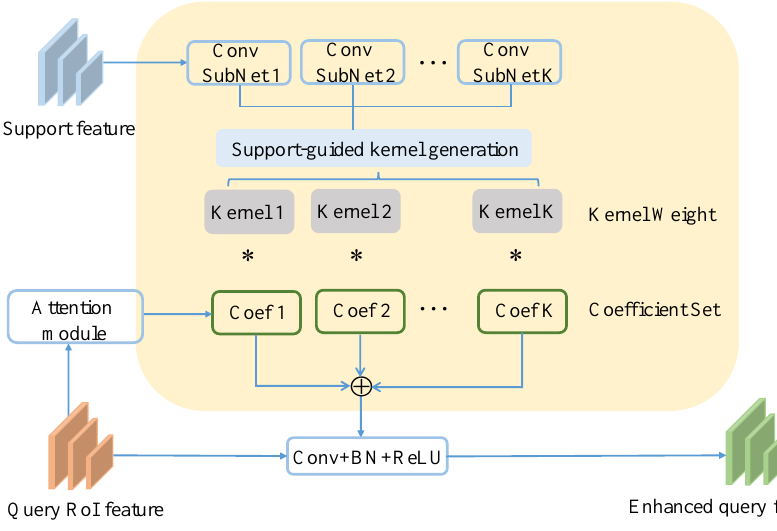
Figure 3. The structure of generating support-related kernel in support-guided query feature en- hancement module. ∗ and ⊕ means the aggregation operation of different convolutional